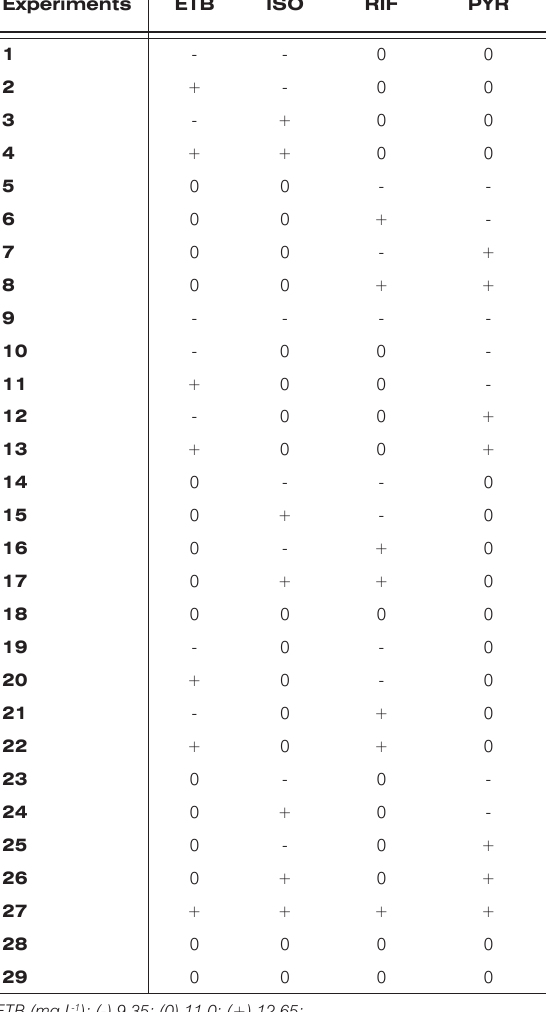
Table 2. 3 4 Box-Behnken design matrix. Experiments